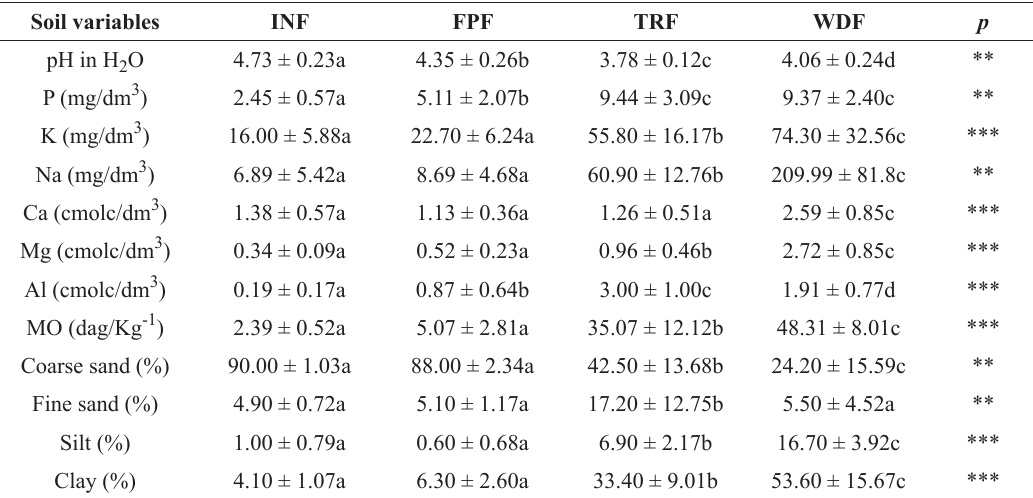
Chemical and physical soil variables (0-10) in four forest types analyzed in Jacarenema Natural Municipal Park, Vila Velha, Brazil. p = significance level. INF=Inundated Forest; FPF=Floodplain Forest; TRF=Transitional Forest; WDF=Well-drainedForest. Each line shows the value of the soil variable in each forest type. Similar letters denote values that could not be differentiated by the Tukey test (p ≤0.05).